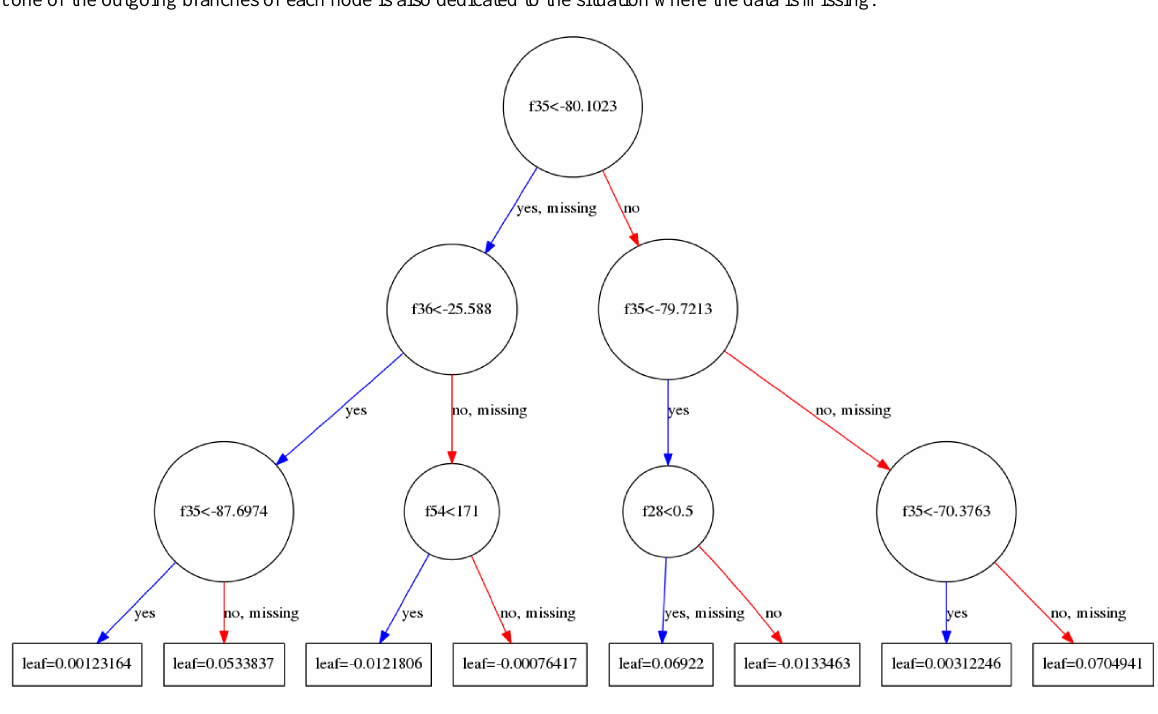
Figure 3. An example of a single decision tree in the ensemble of decision trees. Each circle is a tree node, where a decision is made by comparing a feature value fxx to a threshold. For a given feature vector, depending on which path is taken, a single prediction score is generated, shown in the boxes. Note that one of the outgoing branches of each node is also dedicated to the situation where the data is missing.